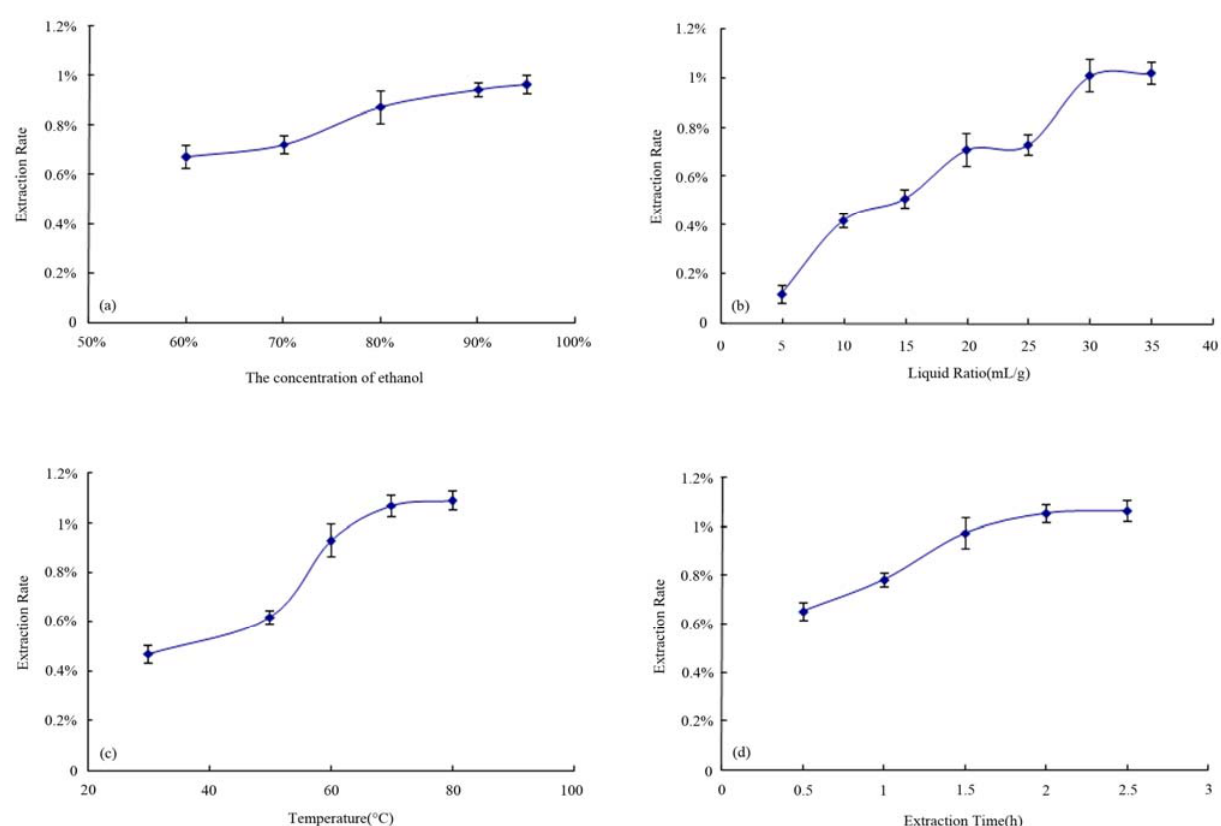
Figure 2. Results of single-factor